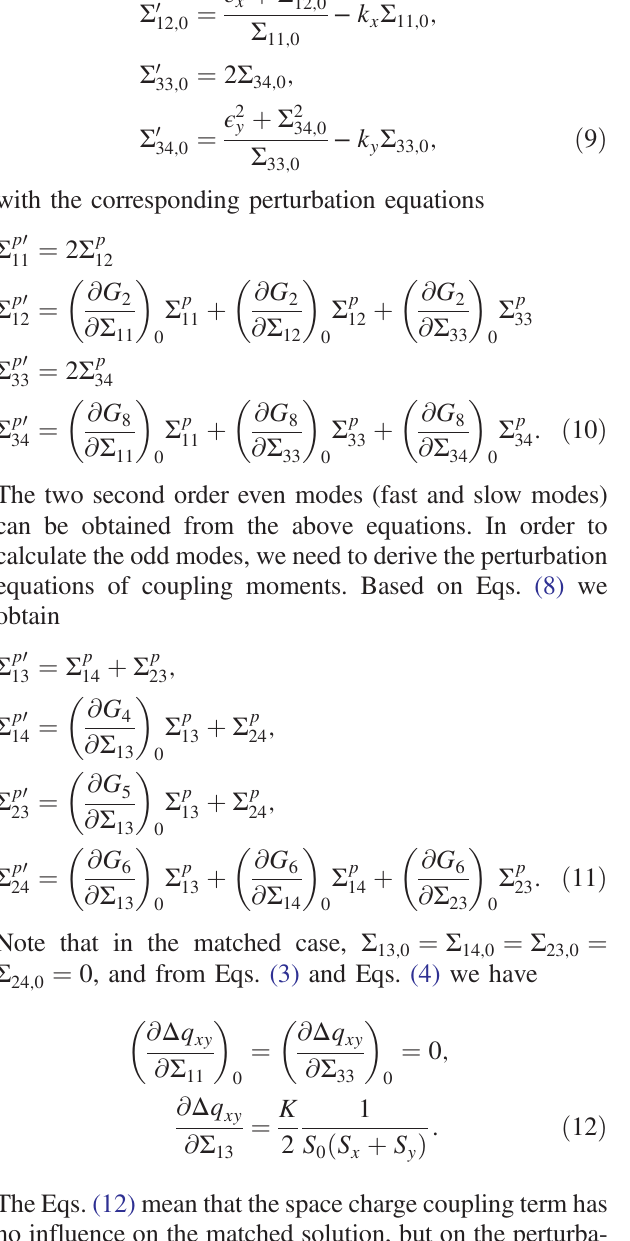
x in a constant focusing